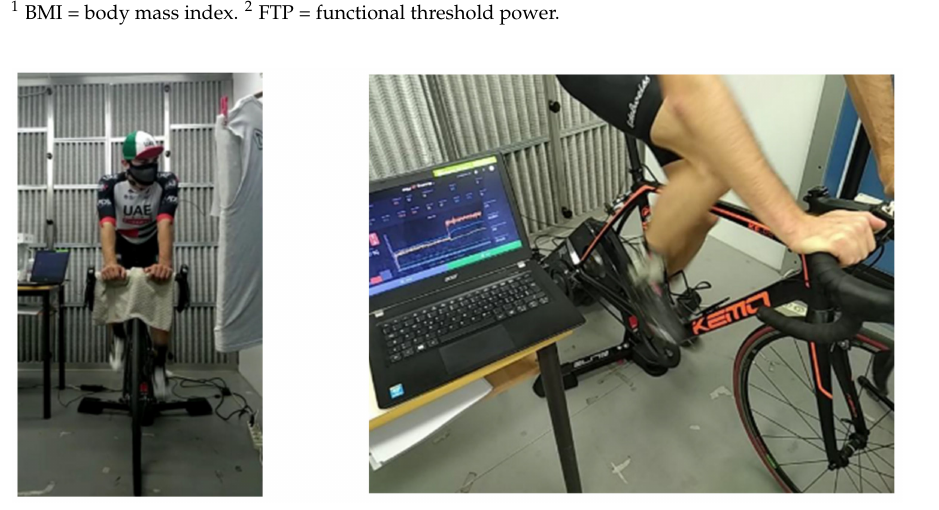
Figure 2. Experimental